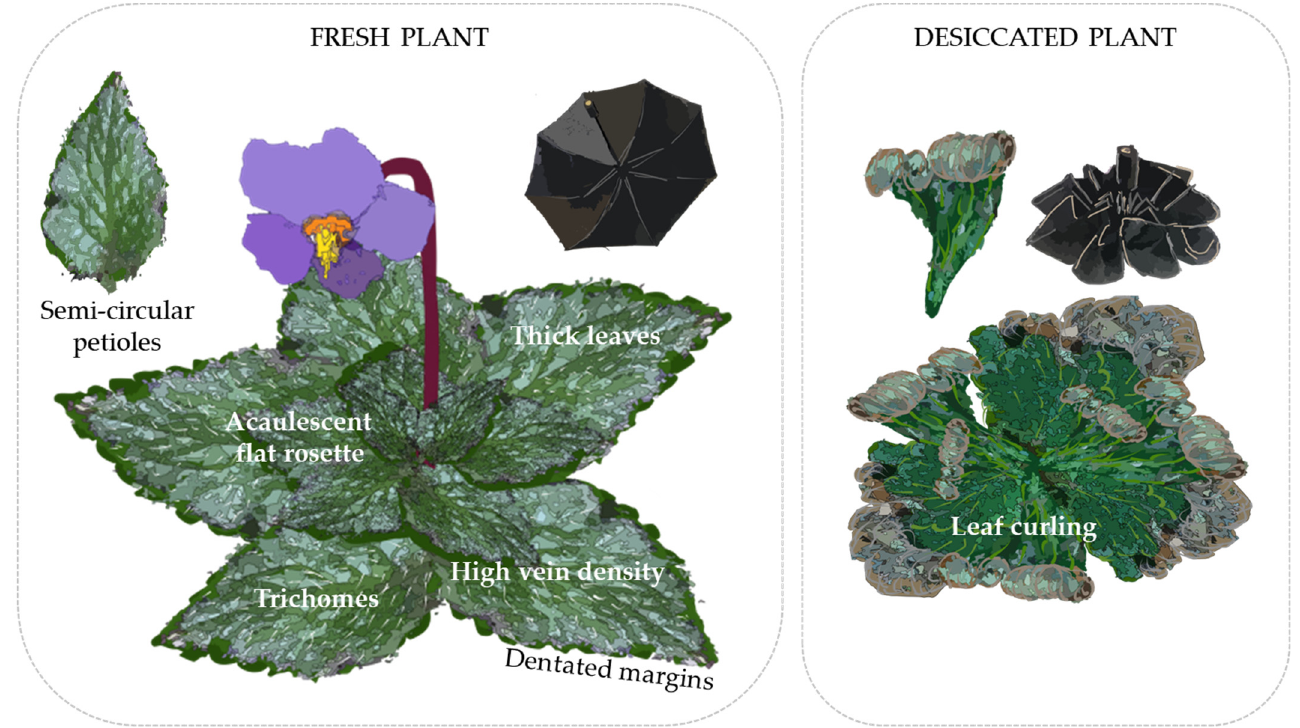
Figure 4. Morphological preadaptations of gesneriads to desiccation. A foldable umbrella is used as an analogy of the structural requirements for a successful process of leaf curling.